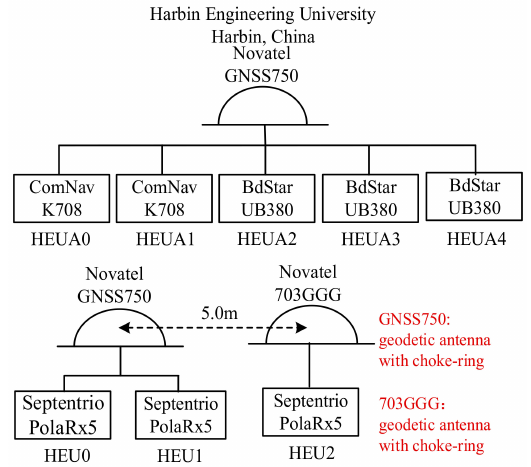
Figure 2. Receivers and antennas setup.